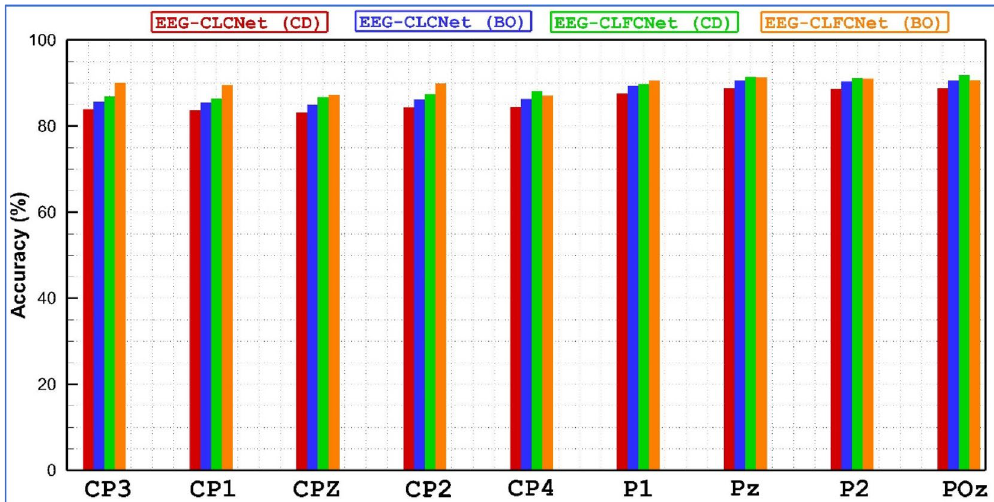
Figure 7. Accuracy of BCI Competition IV dataset 2a channels for the customized networks, with or without use of FNB and with two hyperparameter tuning methods. The horizontal axes presents the Frontal lobe channels (CP3, CP1, CPz, CP2, CP4, P1, Pz, P2, POz) and the vertical axes presents the accuracy.